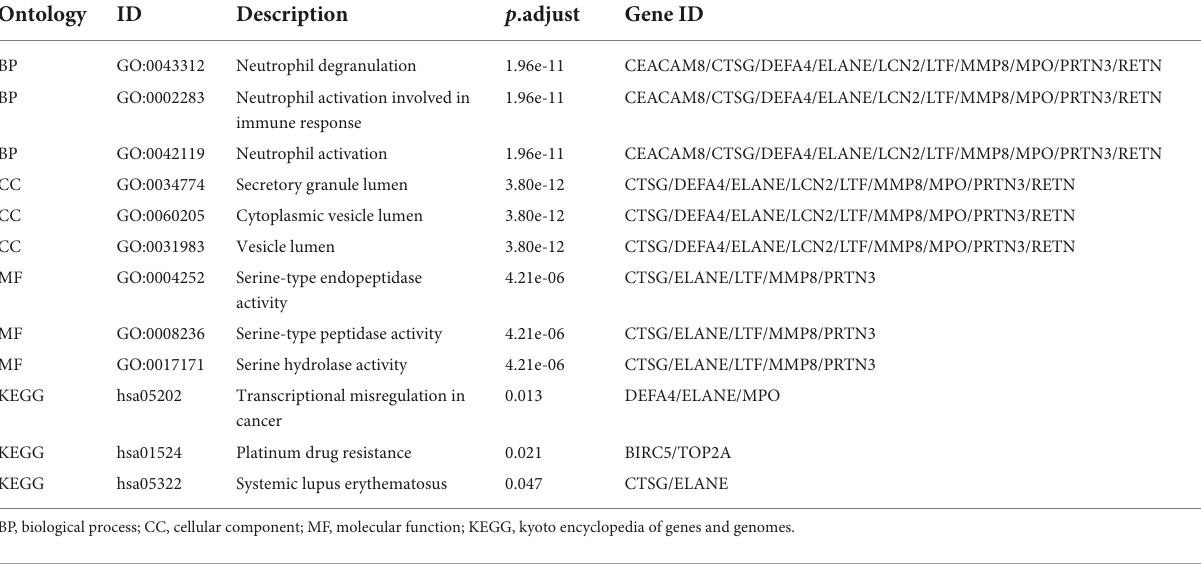
TABLE 4 GO and KEGG analysis of 14 common hub genes.